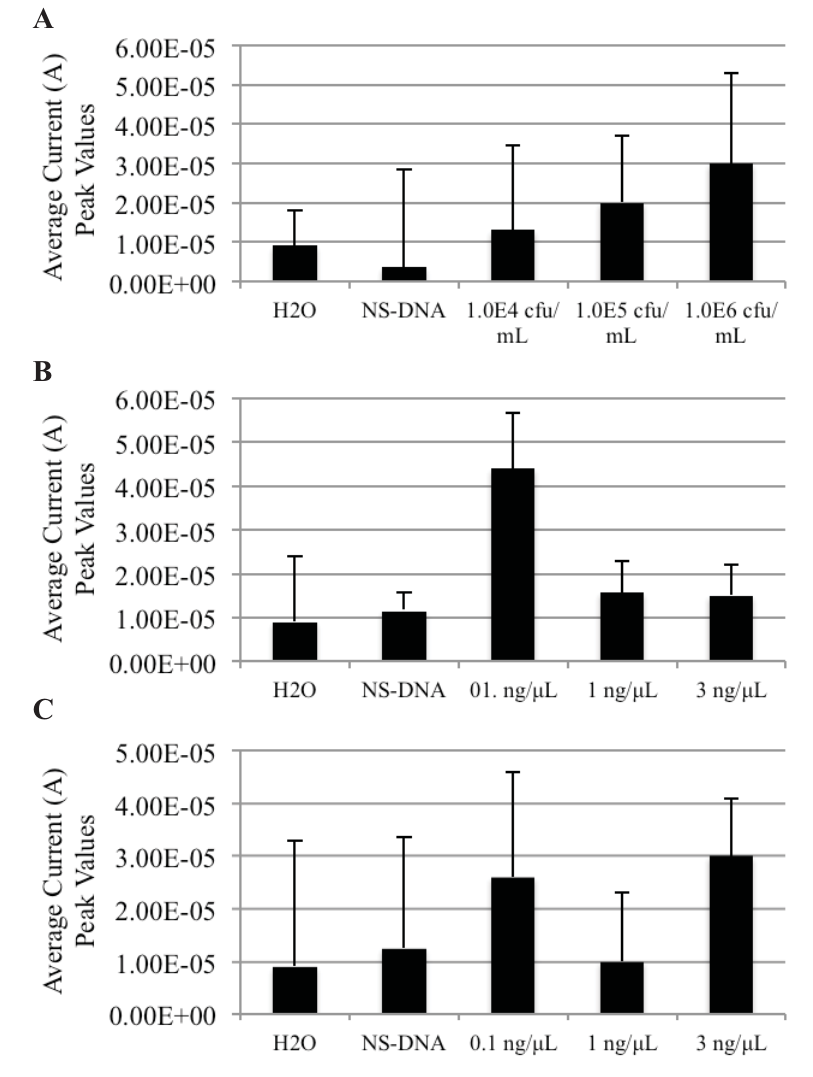
Figure 4. Non-PCR amplified S. enteritidis genomic DNAt can be detected in basic liquid food matrices using the AuNP-DNA biosensor. Graphs represent the average differential current peak values vs. DNAt concentration. ( A ) TRIzol ® extracted genomic DNAt from 2% milk spiked with PBC; ( B ) TRIzol ® extracted genomic DNAt from 2% milk spiked with MBC; ( C ) Phenol/ethanol extracted genomic DNAt from 2% milk spiked MBC. H blank control; NS-DNA, non-specific PCR amplified B. anthracis DNAt (0.1 ng/μL) negative control; HCl, 1M hydrogen chloride. Graphs represent the average value of duplicate samples for each condition. Error bars represent the standard deviation of the